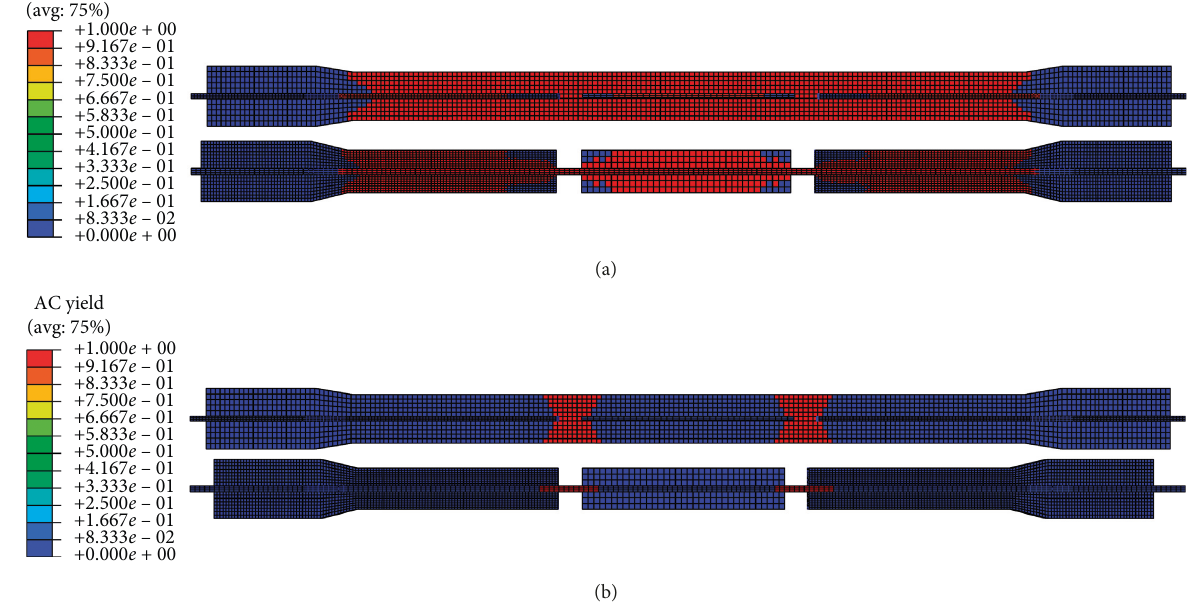
Figure 19: AC YIELD of the BRB-VCC-8 core. (a) Flat-plate segments yield firstly ( δ segments yield soon later ( δ y2 � 1.81and F y2 � 325.9kN). Note: AC yield is 1.0 in the plastic region and is 0 in the elastic